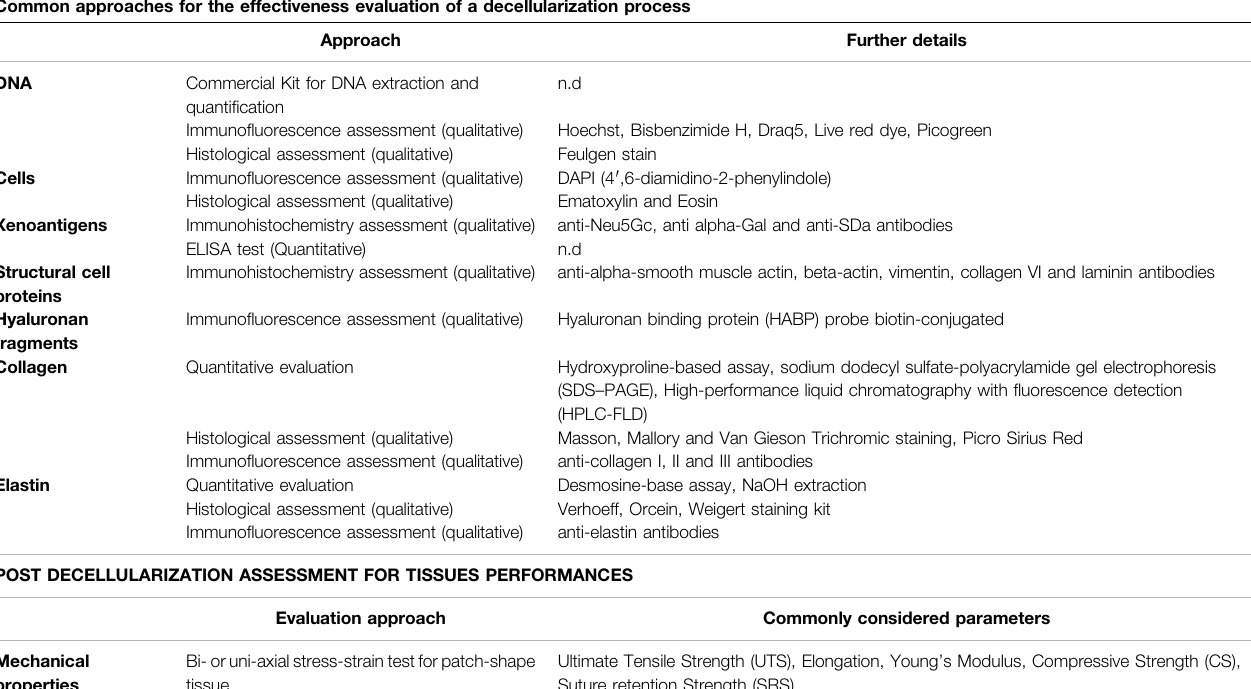
TABLE 4 | Summary table showing the approaches commonly adopted for evaluating the ef fi cacy of decellularization processes and the methods of investigation for highlighting potentially dangerous tissue changes according to the future performance of the implant. Common approaches for the effectiveness evaluation of a decellularization